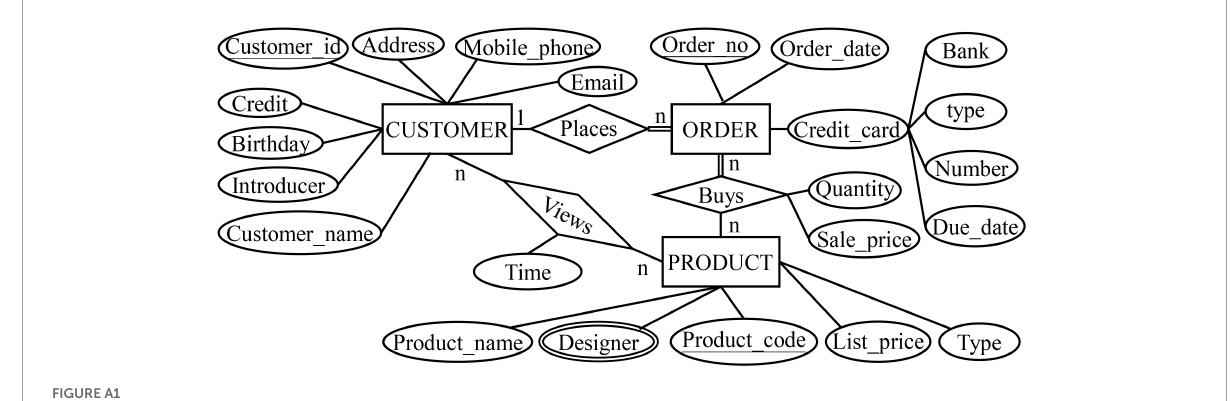
FIGUREA1 ER diagram of the e-bookstore